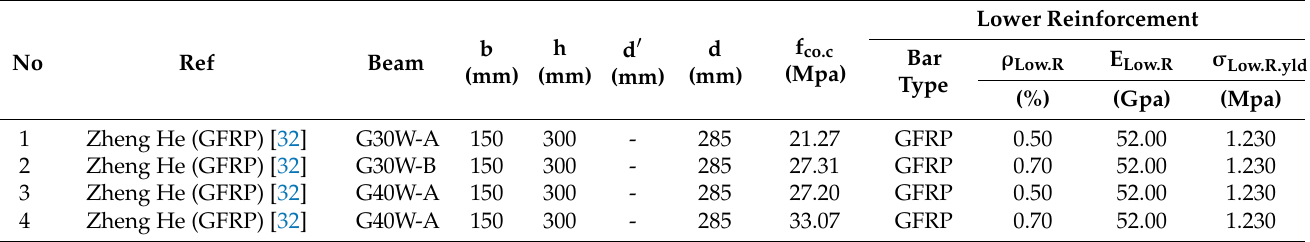
Table 2. Test data parameters for four glass FRP RC beams.